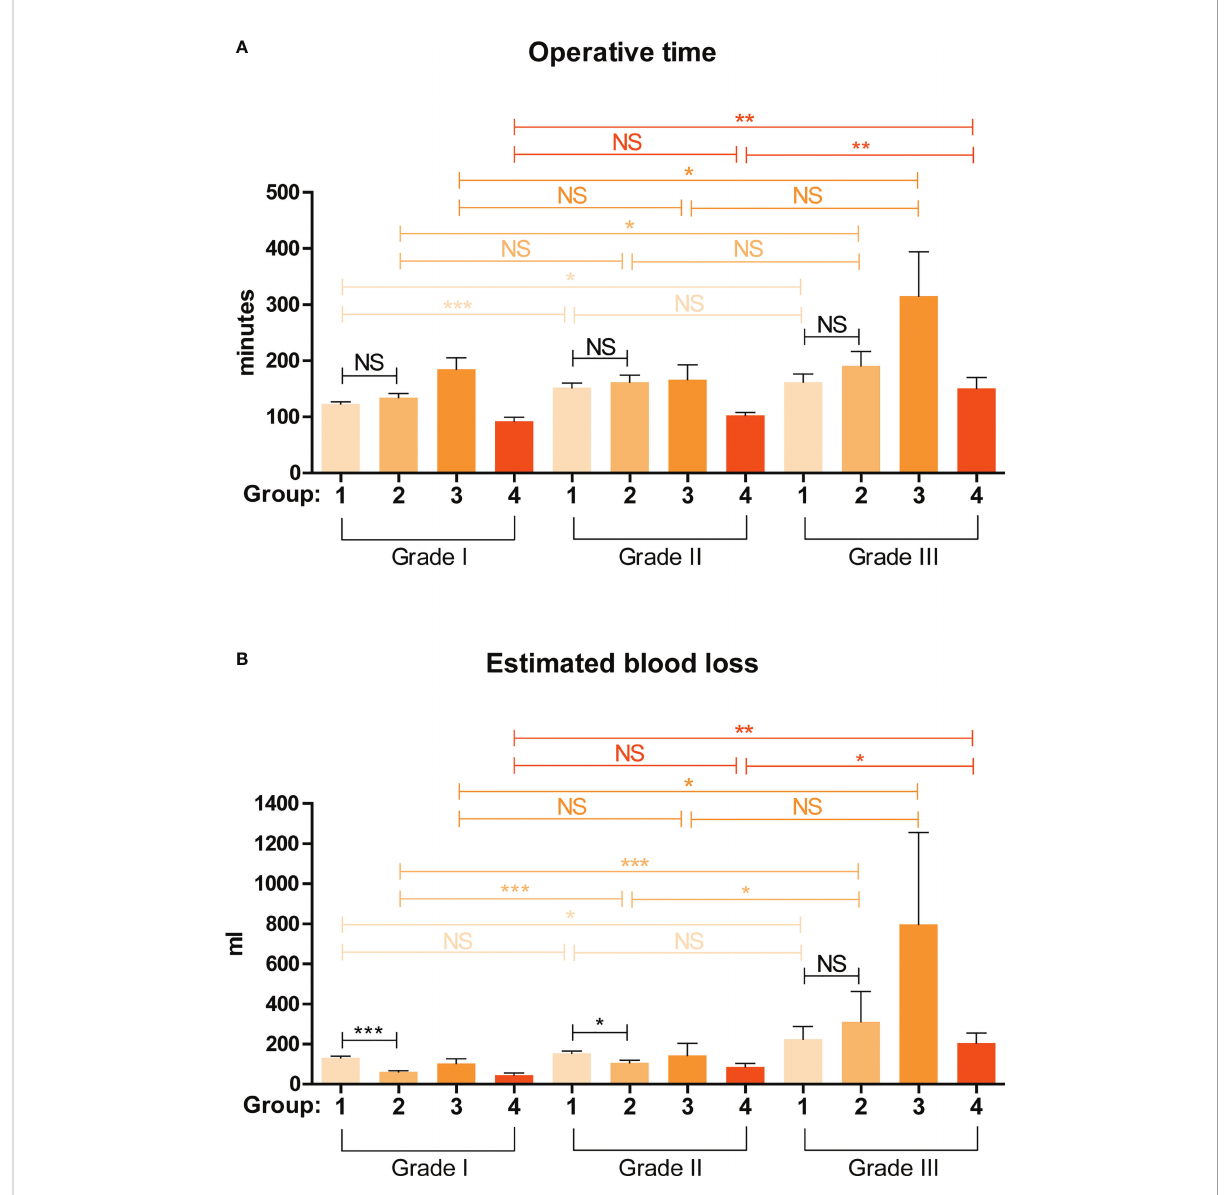
FIGURE 4 Validation of the predictive value of a grading system based on the ADRENAL score in OT and EBL. A 4-grade classi fi cation for adrenal masses was proposed based on the ADRENAL score. Grade 0: ADRENAL score = 0; Grade I: ADRENAL score < 4 (1-3); Grade II: ADRENAL score ≥ 4 but ≤ 7 (4- 7); Grade III: ADRENAL score > 7 (8-12). Student t test was performed to analyze the difference in OT and EBL. A p value <0.05 was considered statistically signi fi cant. (*p < 0.05; **p < 0.01; ***p < 0.001; NS, not signi fi